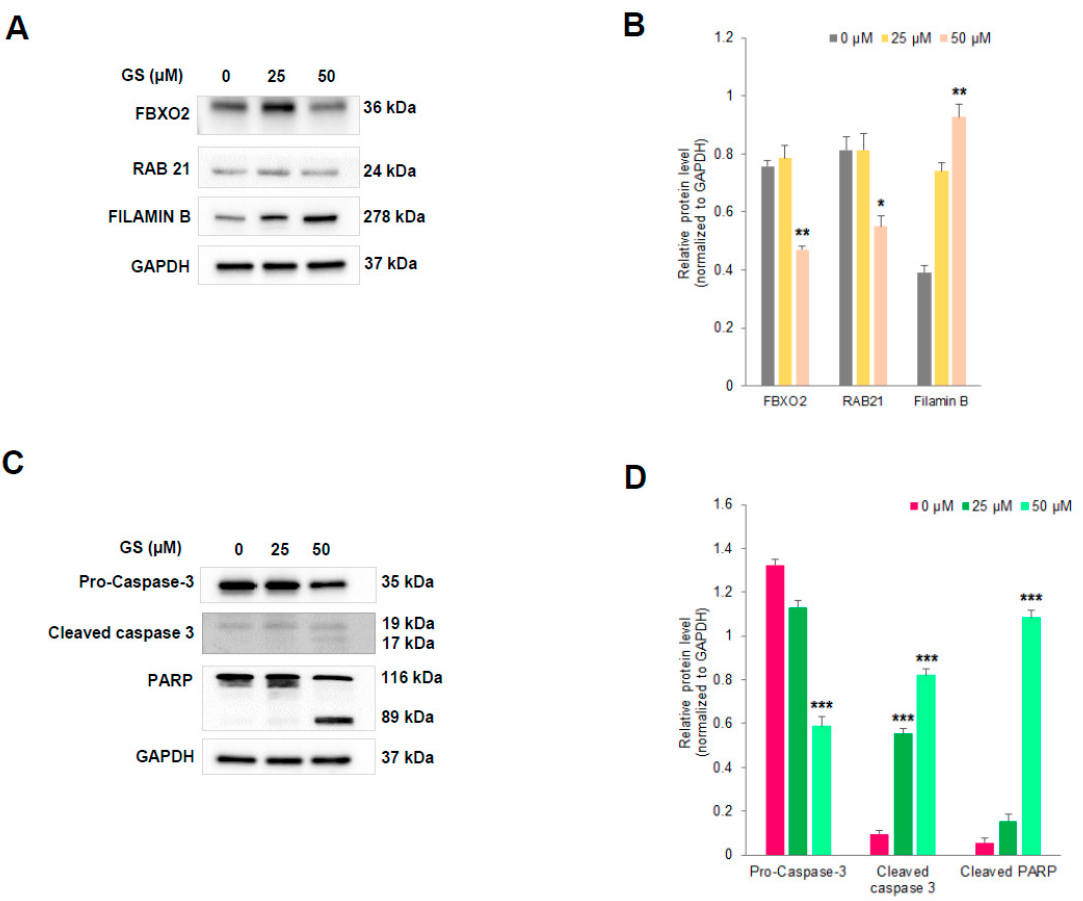
Figure 8. Validation by western blot analysis. ( A , C ) HCT 116 cells were treated with increasing doses of GS (as indicated) for 48 h and cells were lysed for western blot analysis with the antibodies FBXO2, RAB21, Filamin B, pro-caspase-3, cleaved caspase 3, and PARP. GAPDH served as the loading control. ( B , D ) Relative protein levels quantified by densitometry analysis. * p < 0.03, ** p < 0.002, *** p < 0.0001.